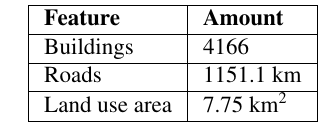
Table 2. Mapping results of the first course meeting. Source: resultmaps.neis-one.org/,